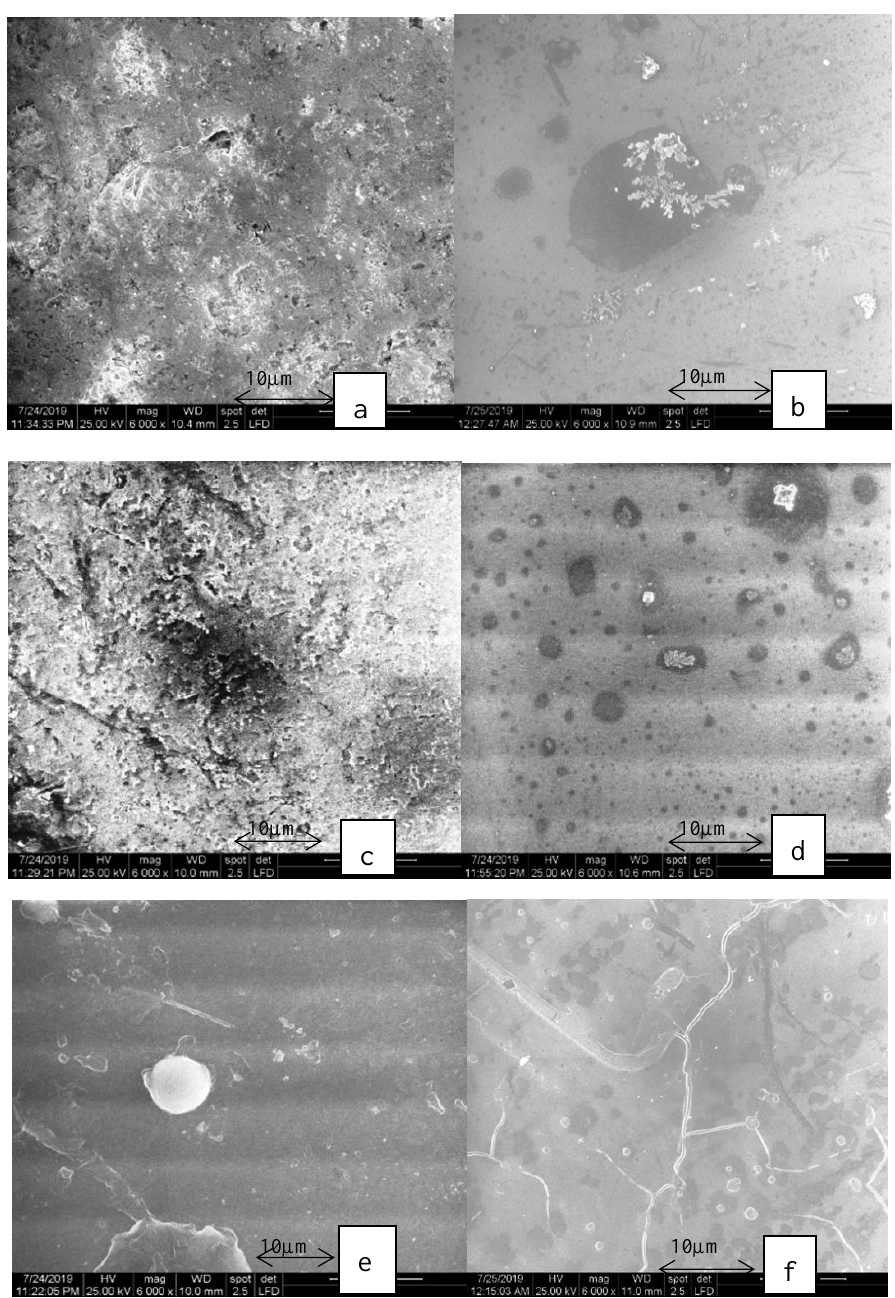
Figure 8. SEM images of the milled glass-ceramic specimens after thermocycling. ( a ) FMP samples; ( b ) FMG samples; ( c ) LDMP samples; ( d ) LDMG samples; ( e ) ZLSMP samples; ( f ) ZLSMG samples.